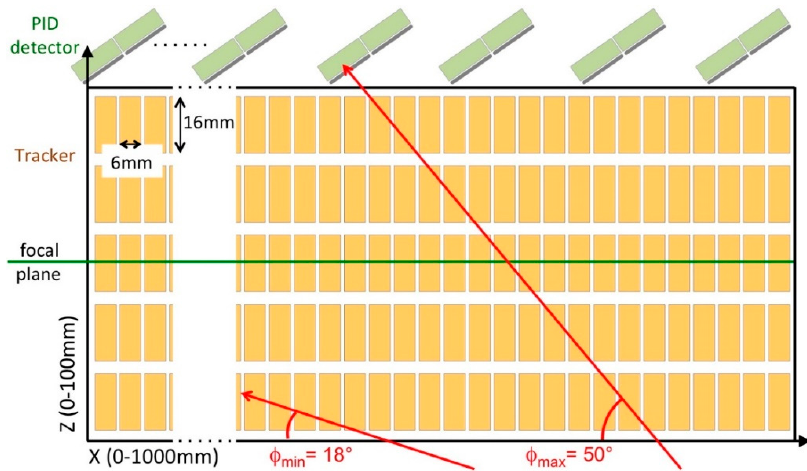
Figure 21. Sketch of a simulated alternative structure for the tracker readout anode making use of pads. The maximum and minimum impinging angles are reported, as well as the pad size. The focal plane of the spectrometer is assumed at the mid value of the Z coordinate.